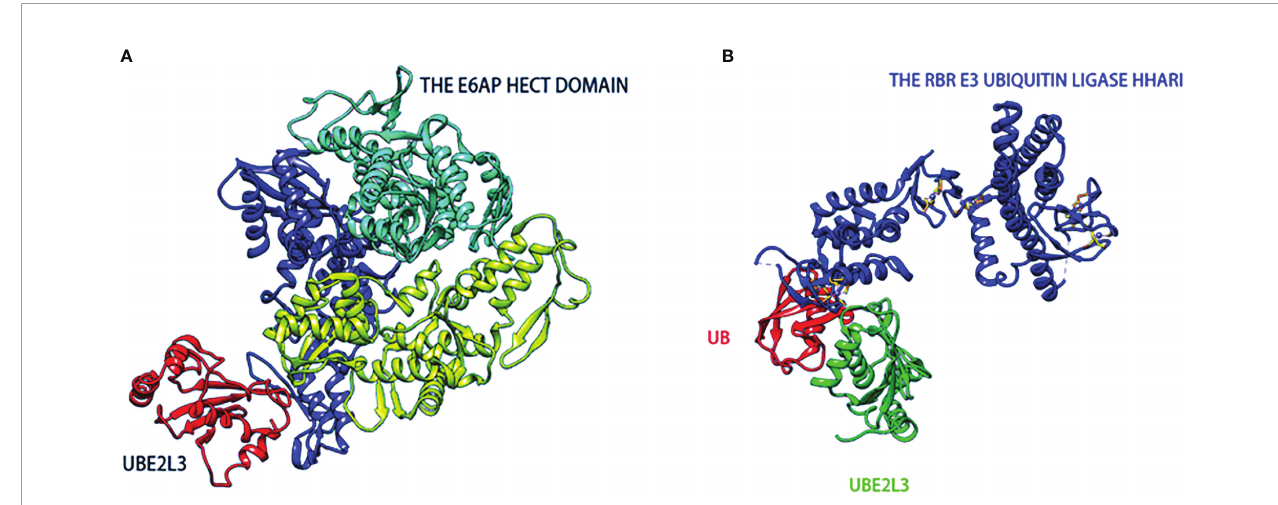
FIGURE 2 | The structures of HECT-type (A) and RBR family (B) E3 ubiquitin-protein ligases in complexes with UBE2L3. (A) The catalytic HECT structure of E6AP is double-lobed (yellow, blue), and there is a large catalytic crack at the junction of the two lobed structures. The crack contains conserved residues(green) formed by mutated interference with the ubiquitin-thioester bond. (B) Ring-in-between-ring (RBR) ubiquitin E3 ligase(blue) binds to Ub(red)-UBE2L3(green) through RING/HECT hybridization